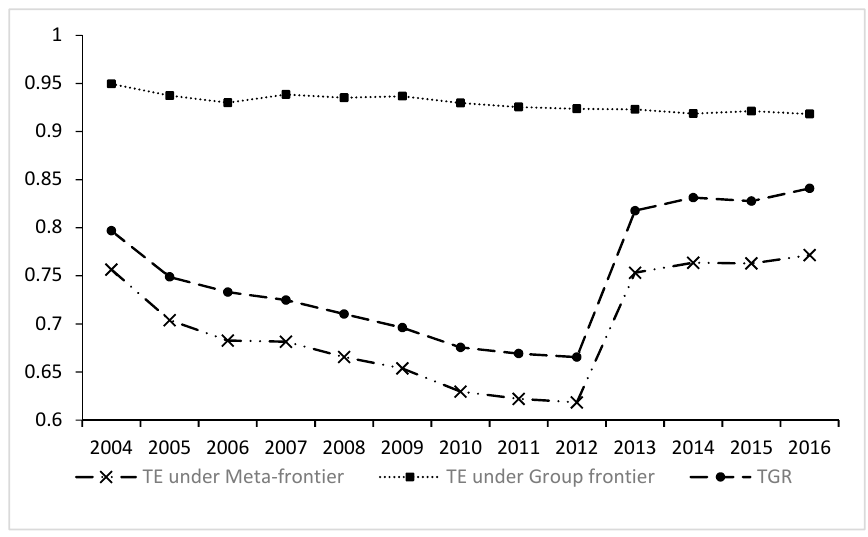
Figure 1. The dynamic trend of the annual average technology gap ratio and its decomposition.